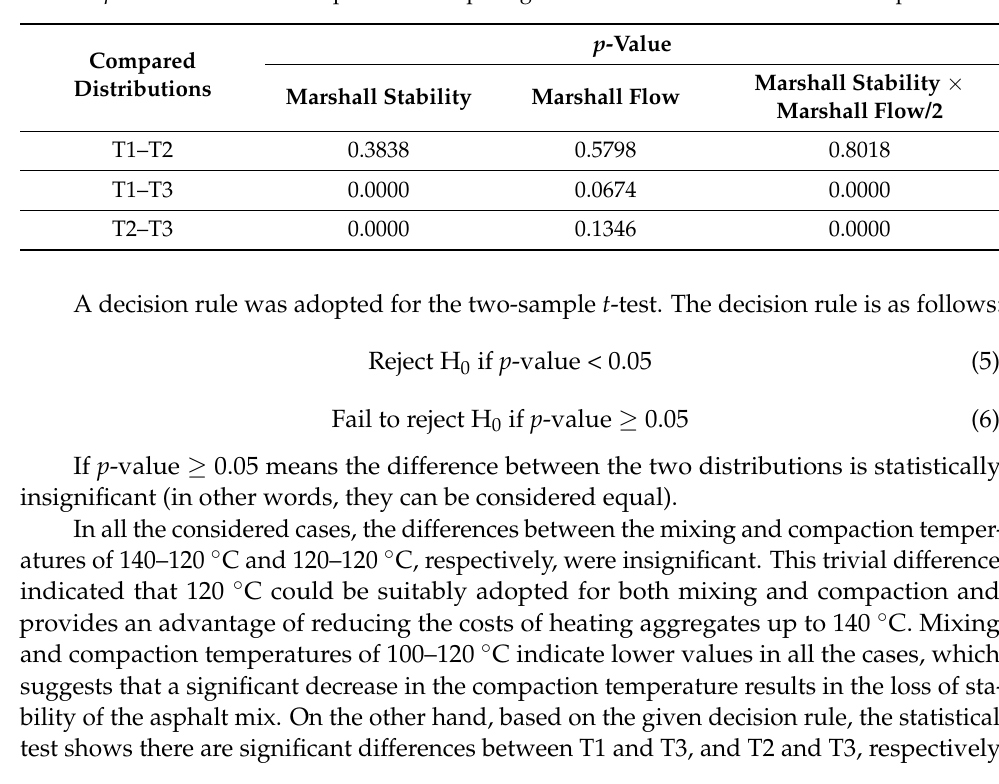
Table 3. p -values from two-sample t -test comparing Marshall test results at different temperatures. Compared Distributions